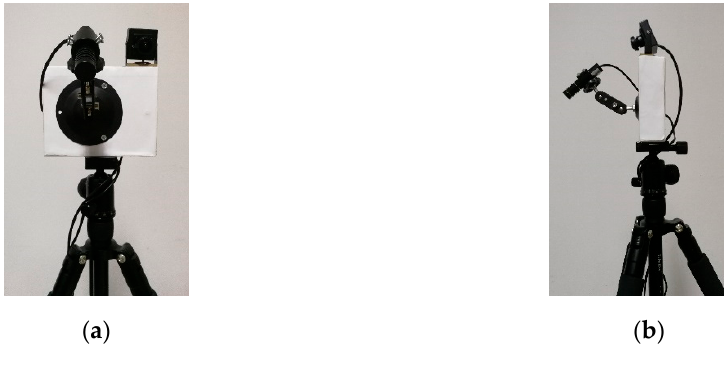
Figure 16 . Experiment platform. ( a ) front view; ( b ) side view.